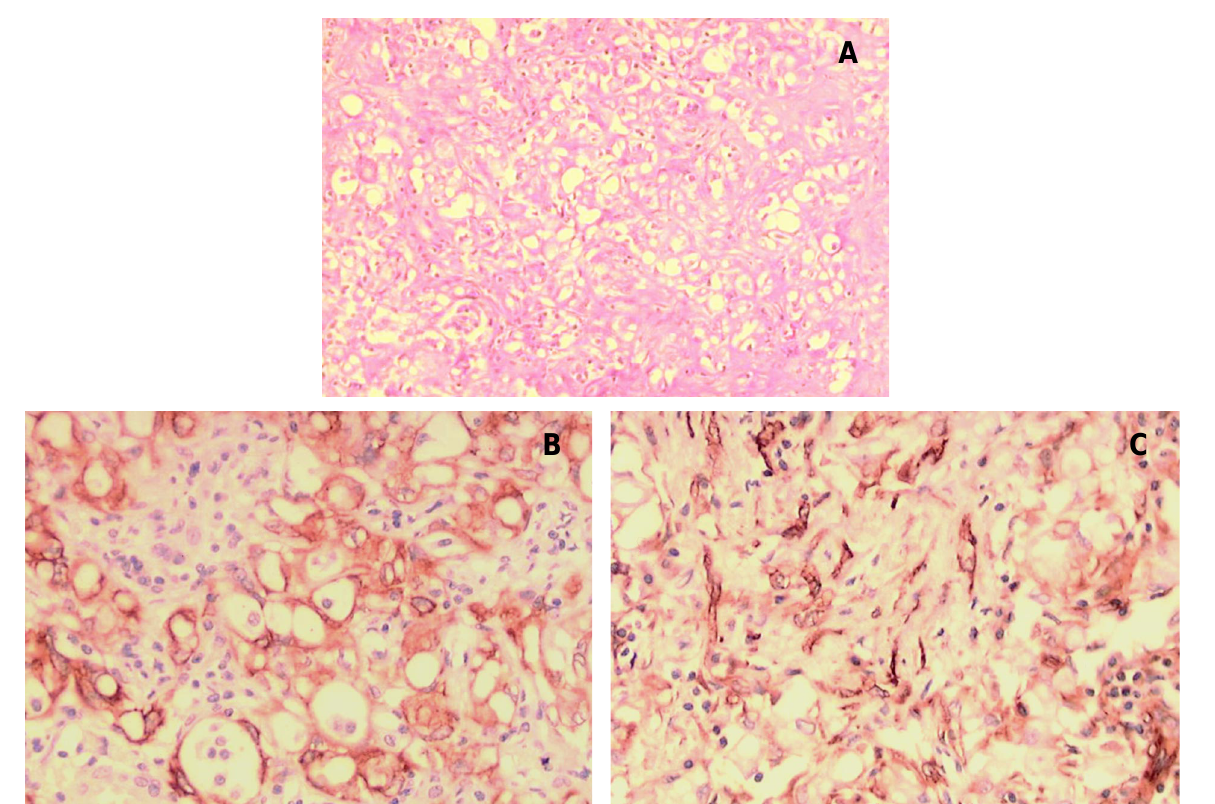
Figure 1 – Histological and immunohistochemical studies of the adenomatoid tumor of adrenal gland. A) Proliferation of mesothelial cells similar to epithelial lineage cells, arranged as small tubules, cysts, or string-shaped (HE, X80). B) Positivity for cytokeratins in epithelial-like cells. CEA negative. Positive to AE1 and AE3 (Imunolabeling, X200). C) Positivity for vimentin expressed in mesothelial cells (Imunolabeling,